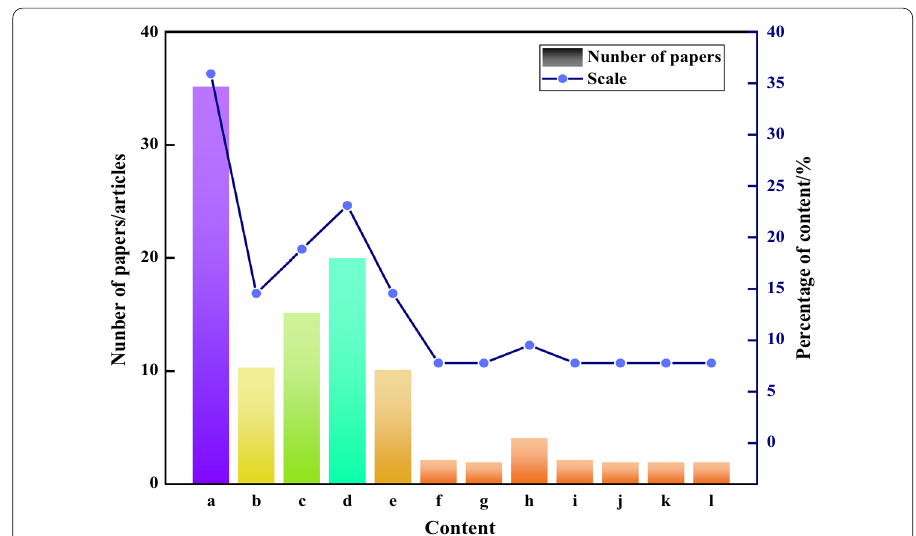
Fig. 3 Comparison of content and quantity of ecological footprint studies in